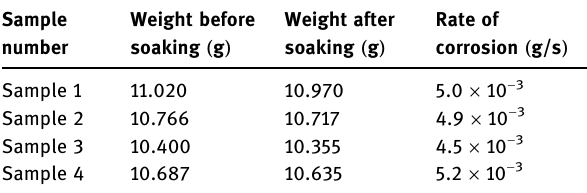
Table 5: Corrosion rate of samples 1 – 4 Sample